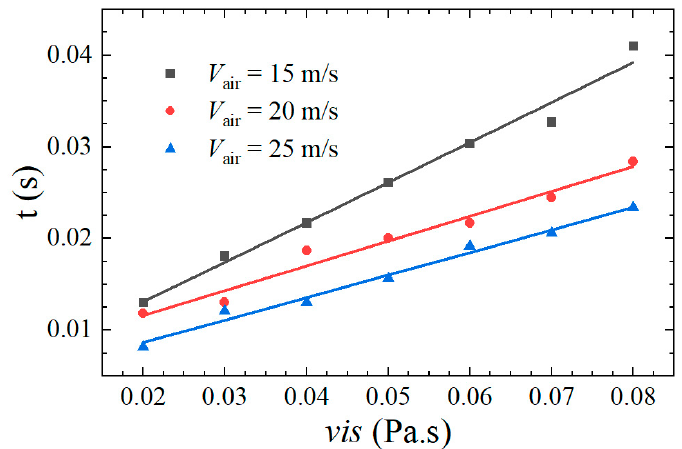
Figure 12. Variation in drying time with water-based ink viscosity.